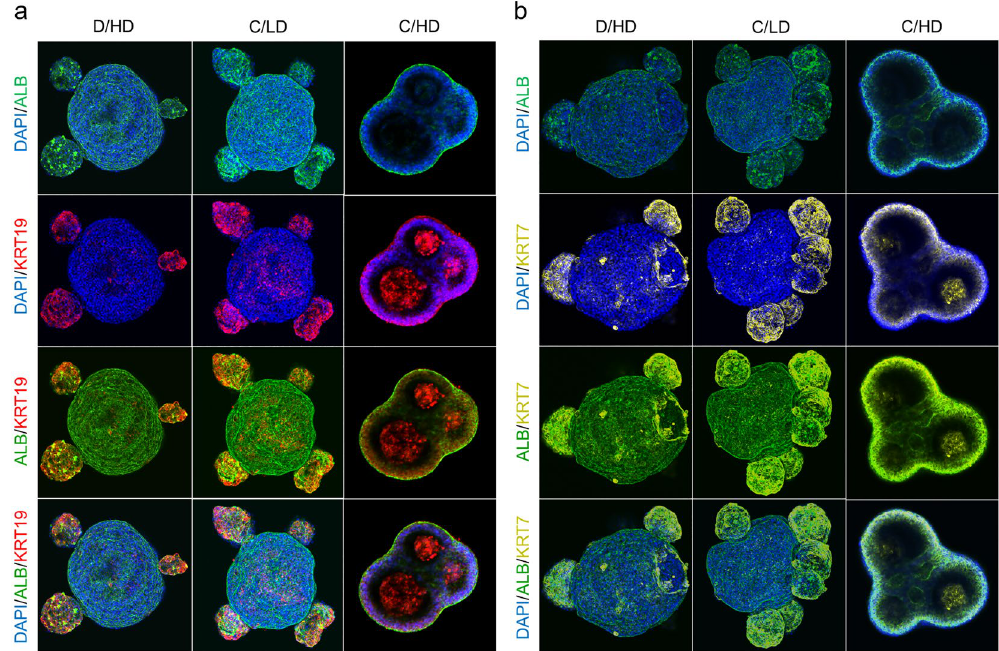
Figure 6. Characterization of differentiated human liver organoids (HLOs). The co-expression of cholangiocytes markers KRT19 (red) ( a ) and KRT7 (yellow) ( b ) were co-localized in the cystic region of the HLOs expressing ALB